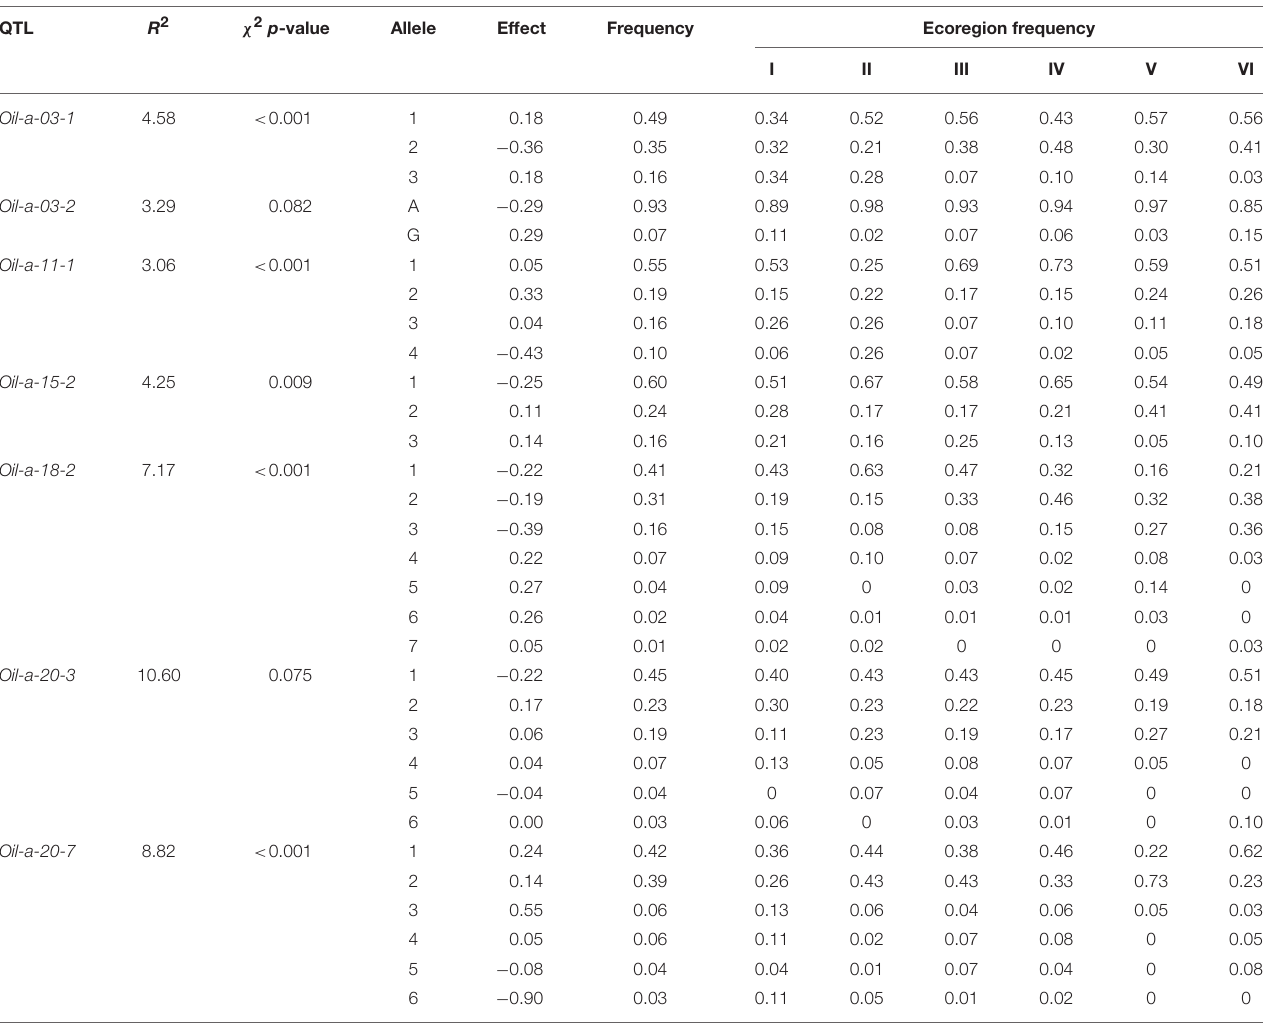
TABLE 6 | Allele frequency distribution for large effect ( R 2 > 3%) seed oil content QTL in CSLRP. QTL R 2 χ 2 p -value Allele Effect Frequency Ecoregion